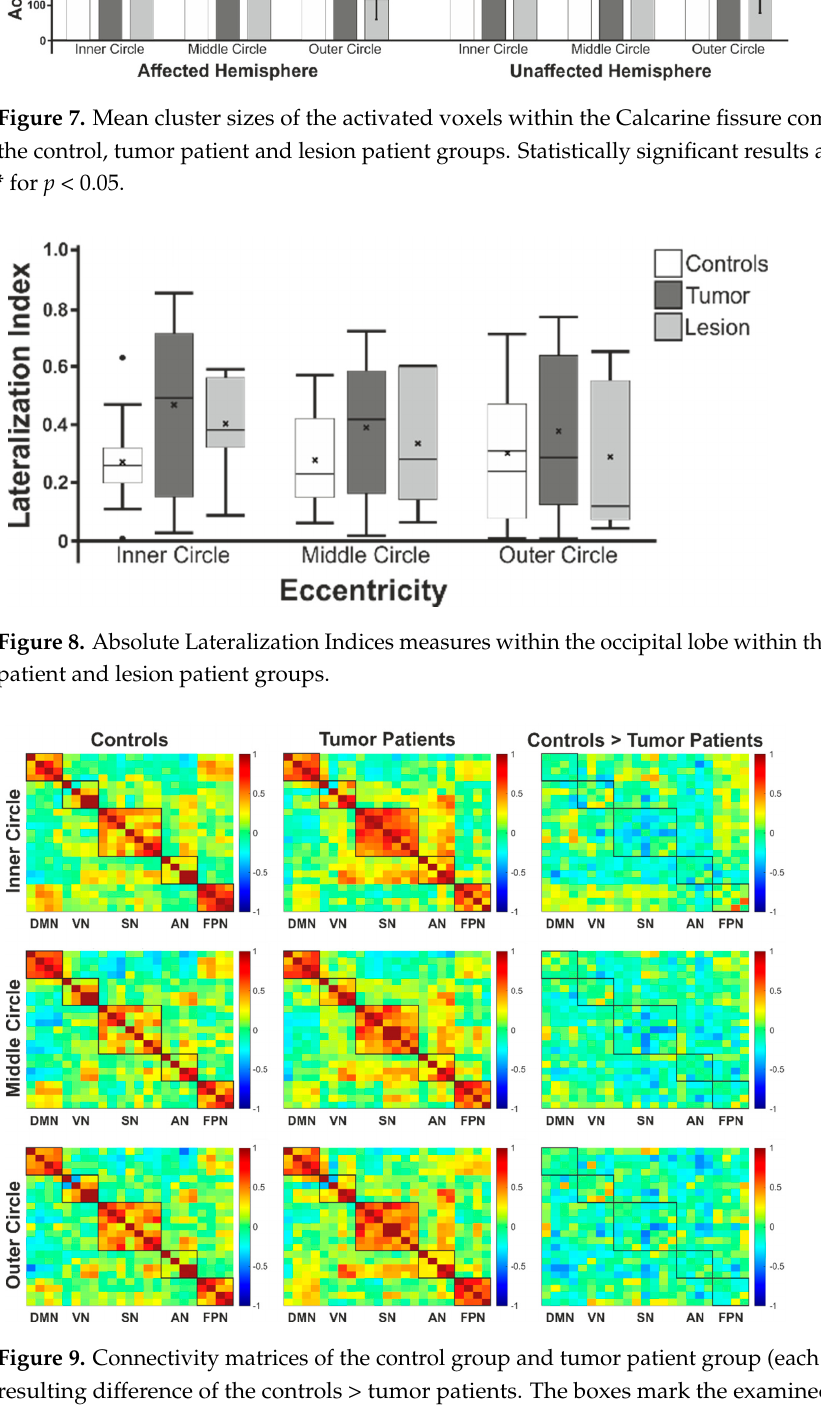
Figure 7. Mean cluster sizes of the activated voxels within the Calcarine fissure compared between the control, tumor patient and lesion patient groups. Statistically significant results are marked with * for p < 0.05.